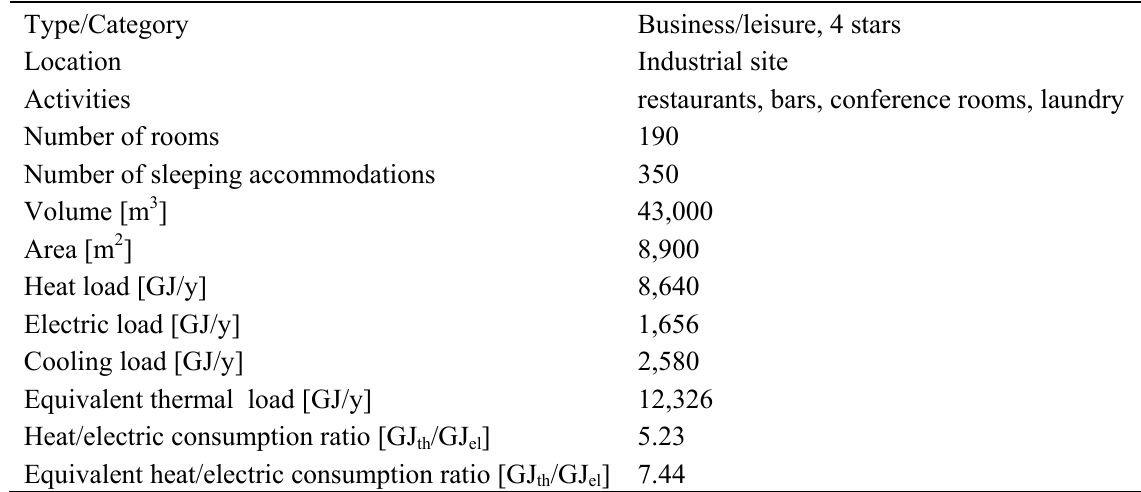
Table 2. End users